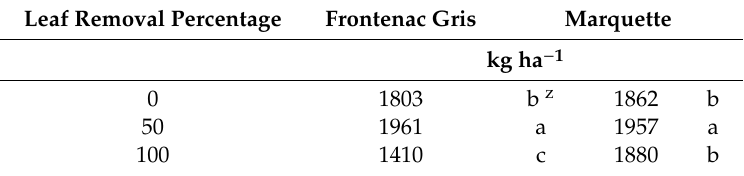
Table 5. E ff ect of fruit-zone leaf removal level on fruit yield for two V. riparia -based cultivars averaged over primary bud retention levels, locations, and years.